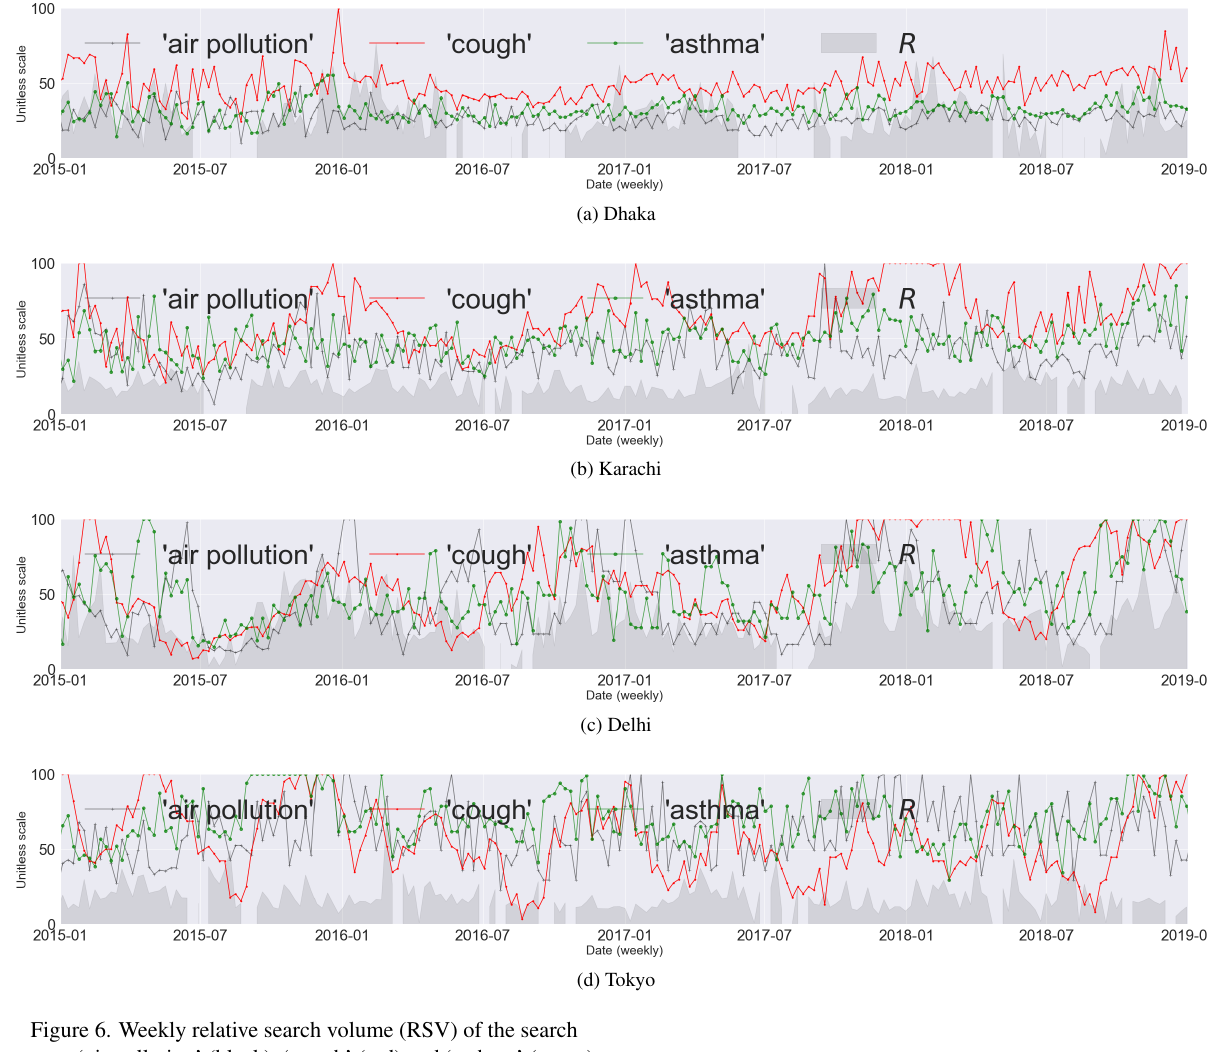
Figure 6. Weekly relative search volume (RSV) of the search terms: ‘air pollution’ (black), ‘cough’ (red) and ‘asthma’ (green) are shown along with the fine aerosol component R (shaded gray) for (a)Dhaka, (b) Karachi, (c) Delhi and (d) Tokyo under study.